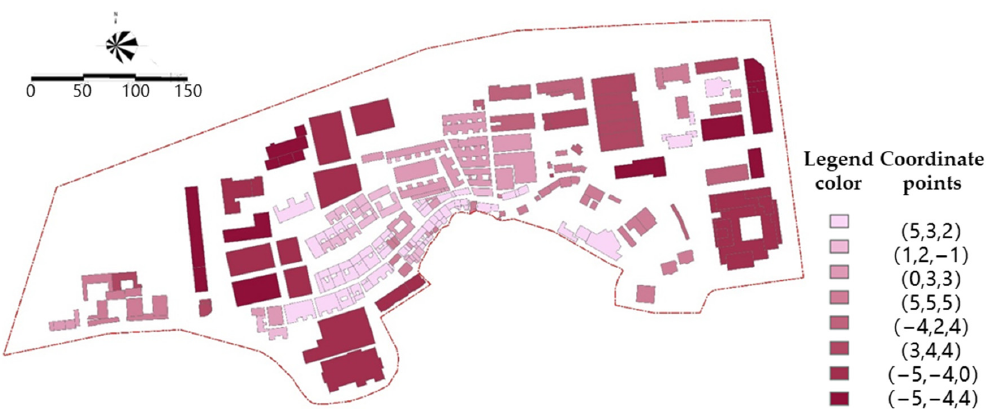
Figure 10. Building attributes clusters after renovation.